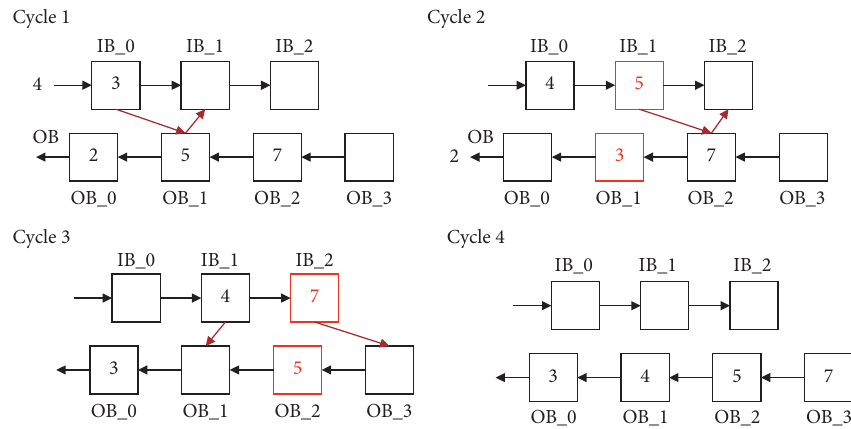
Figure 8: An example of inserting and popping out nodes in the OPEN list.